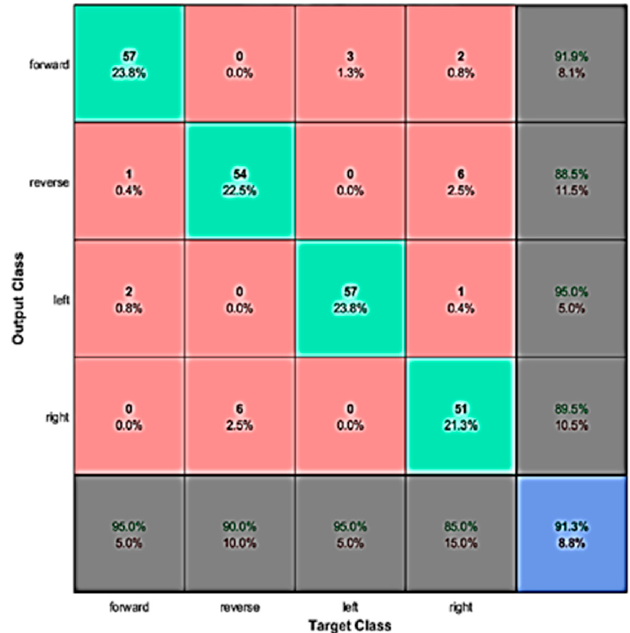
Figure 11. Confusion matrix for male subjects.